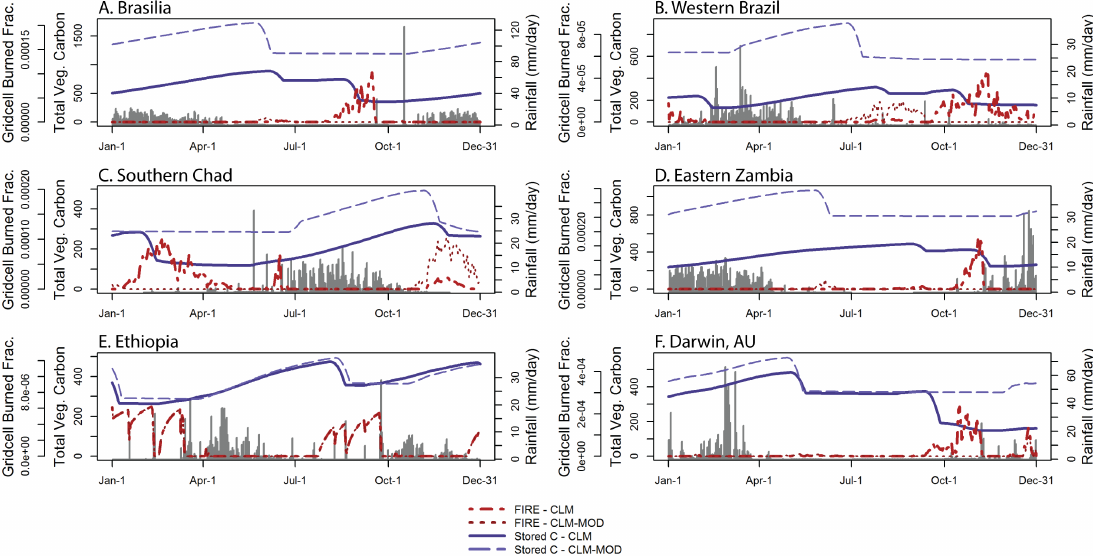
Figure 10. Seasonal cycles of rainfall (mmday − 1 ; gray bars), total vegetation carbon (gCm − 2 ; blue lines), and grid cell burned fraction (day − 1 ; red lines) in CLM and CLM-MOD for 1 year